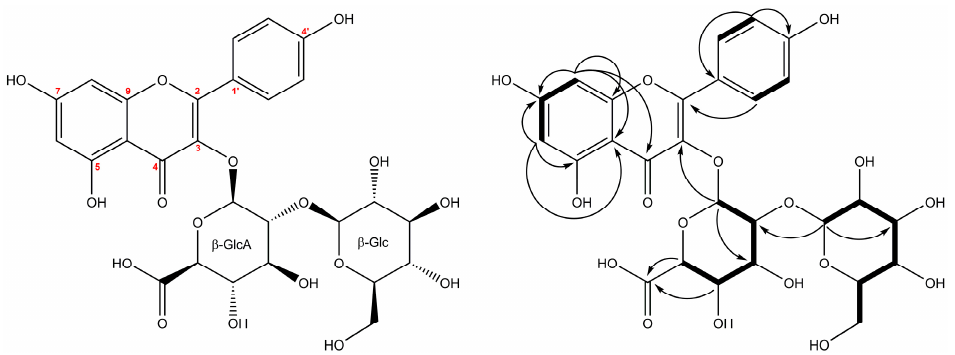
Figure 3. Structure of compound ( 22 ) isolated from the flowers of Z. elegans and key HMBC (H → C) and 1 H- 1 H COSY (—) correlations.